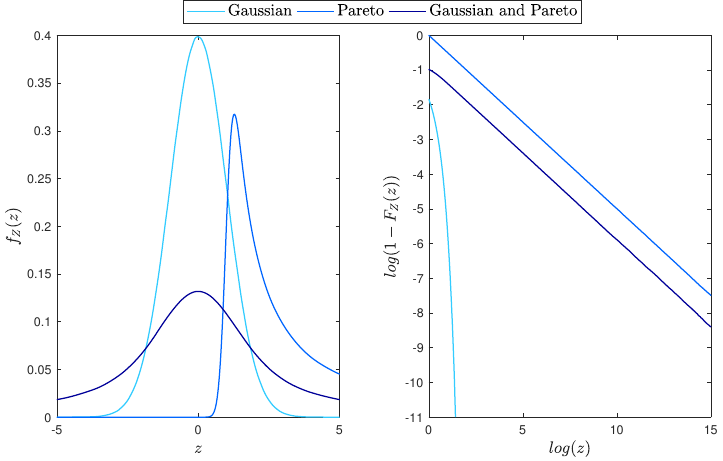
Figure 3. ( Left panel ): the PDF of the random variables X (Gaussian), Y (Pareto) and Z . ( Right panel ): the distribution tails. The parameters are: µ X = 0, σ X = θ Y = 1 and a Y =